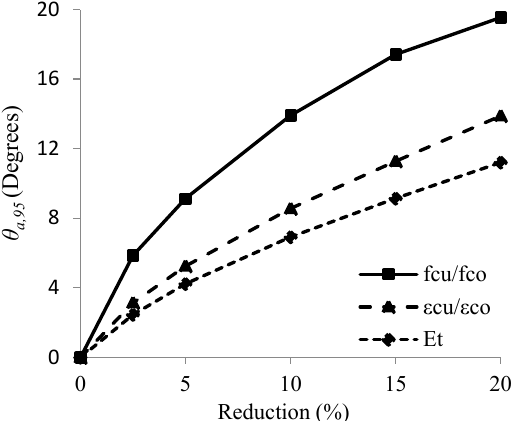
(cid:48) (cid:48) cu / f co and ( b ) E t .